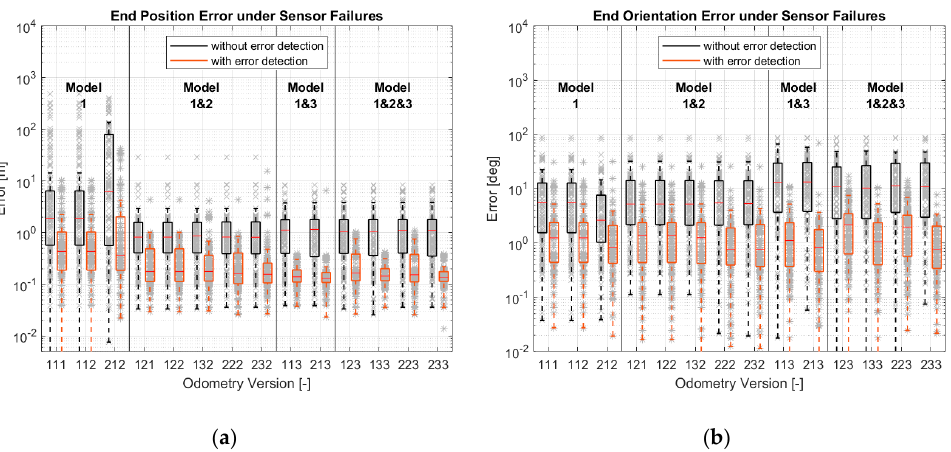
Figure 26. Real driving results of different odometry versions under sensor failures: ( a ) End position errors; ( b ) End orientation errors.